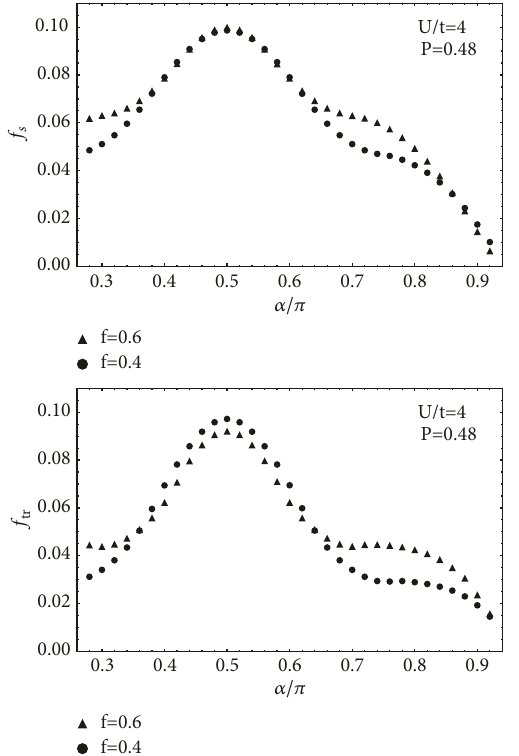
Figure 2: The singlet 𝑓 푠 and the triplet 𝑓 푡푟 contributions to the total condensed fraction 𝑓 = 𝑓 푠 + 𝑓 푡푟 of a Fermi gas in a square optical lattice subject to a non-Abelian gauge field A = (𝛼𝜎 푦 ,−𝛼𝜎 푥 ) . The graphs are obtained by solving the mean field equations along with definitions (19) and (20). The system parameters are the same as in Figure 1.